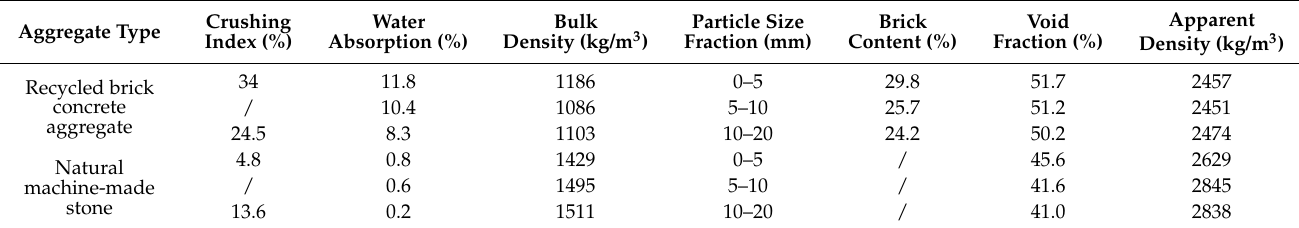
Table 2. Performance indices of raw materials.